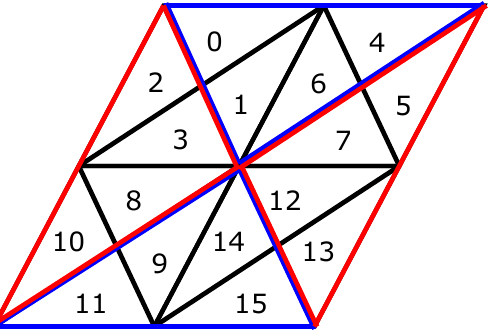
Figure 13. Parent cells are highlighted in blue and red. Note that 16 child cells make up the four parents in the